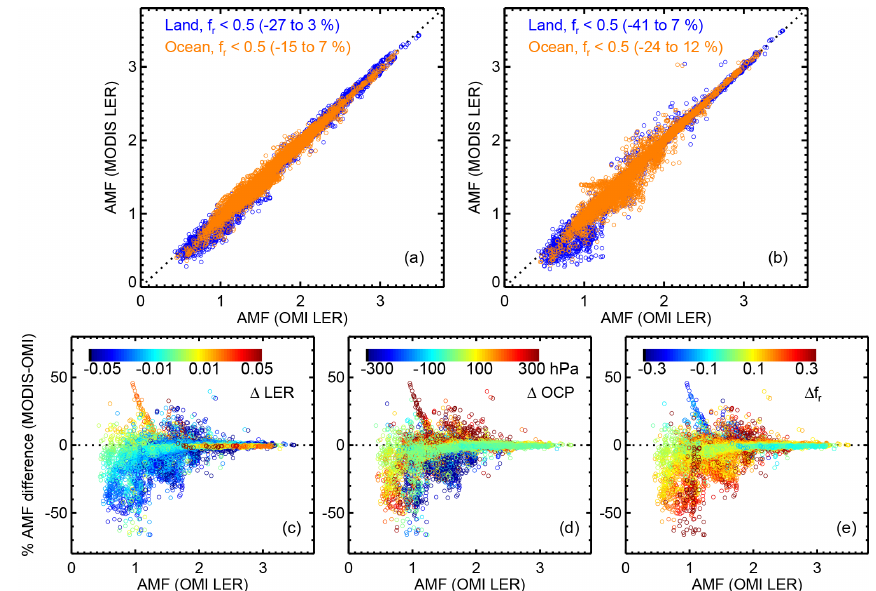
Figure 15. Scatter diagrams of AMFs calculated using geometric-dependent MODIS-based LER vs. OMI-based climatological LER for the orbit 12414 for clear to moderately cloudy sky ( f r < 0 . 5) including (a) effects of BRDF only with clouds unchanged and (b) the effects of both BRDF and O 2 –O 2 cloud parameters for land (blue) and ocean (orange). Numbers in parentheses represent percent difference at the 2nd and 98th percentile range. Percent difference in AMF with changes in surface BRDF and O 2 –O 2 cloud parameters, sorting the data by the difference with respect to (c) LER, (d) OCP, and (e) f r